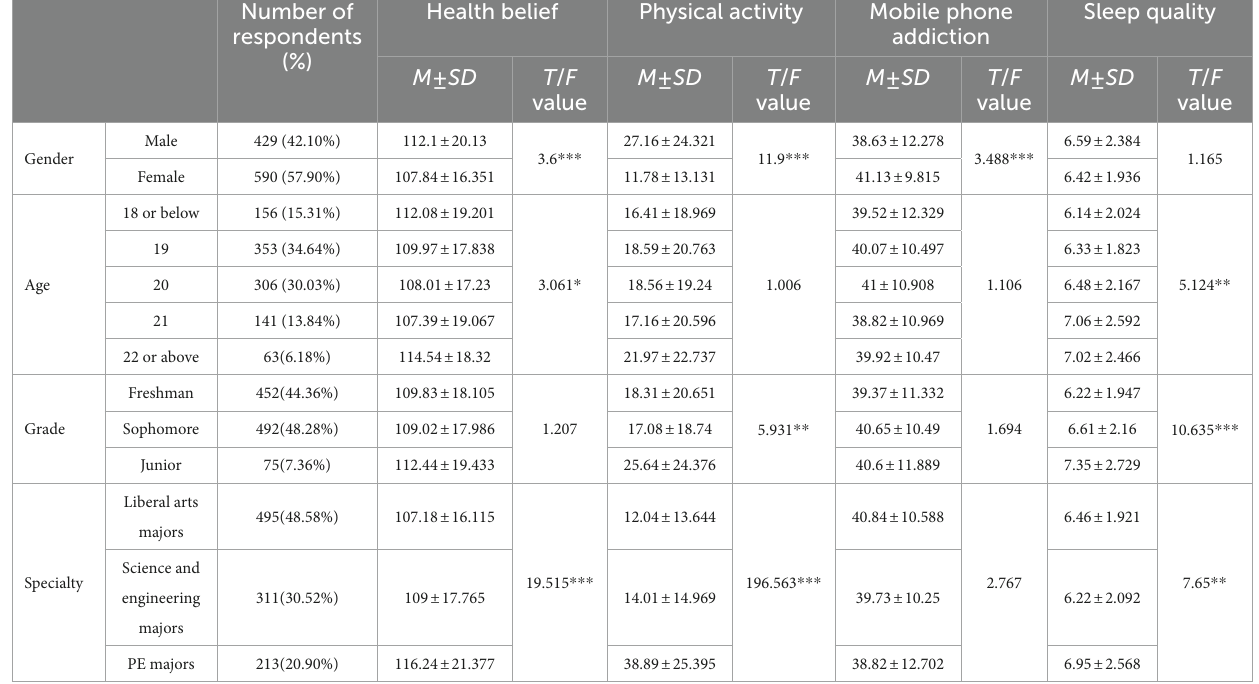
TABLE 1 Description of demographic